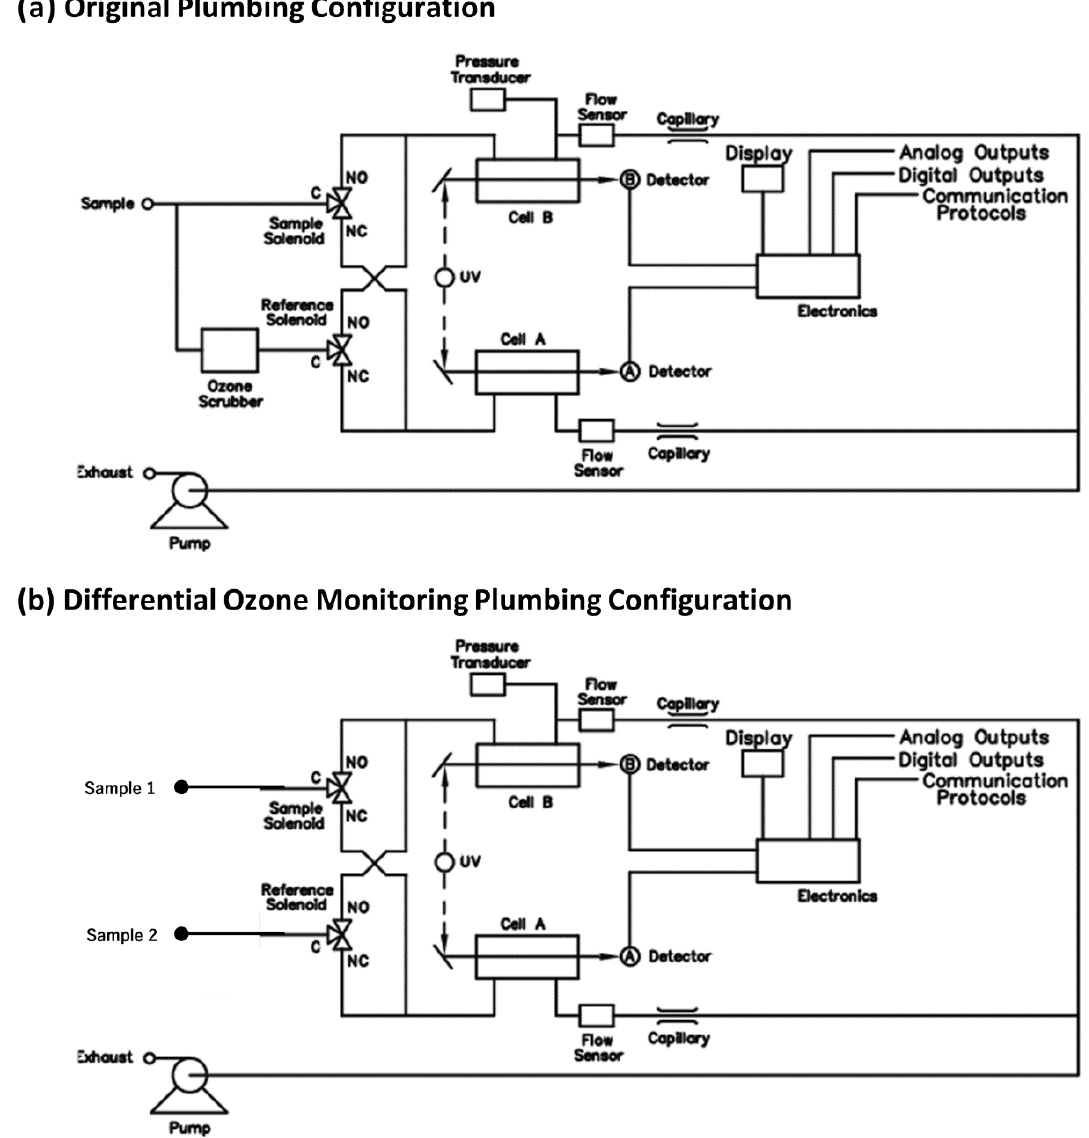
Figure 2. Plumbing of a Thermo Scientific Instruments model 49 ozone UV absorption monitor in its original configuration (a) and in the modified configuration (b) for the direct monitoring of ozone